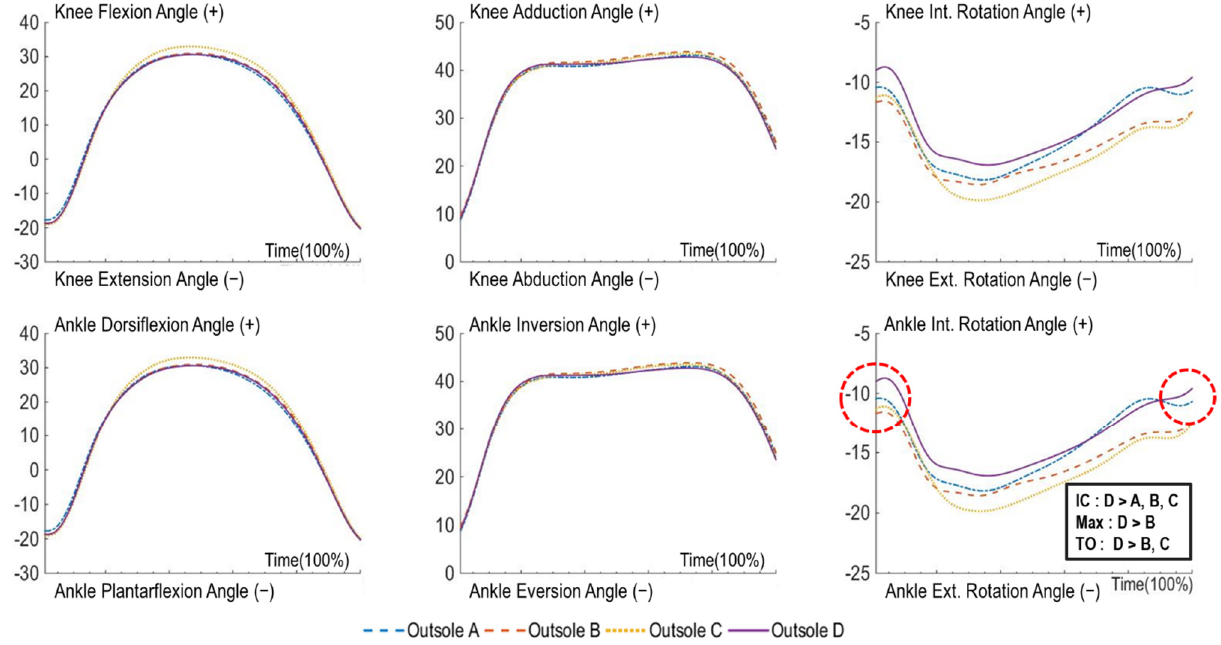
Figure 5. Knee and ankle joints’ angle patterns (mean of 11 participants) upon side braking motion. IC: initial contact, Max: maximum joint angle, TO: toe off. (Dotted red circles represent the significant difference among the outsole tread patterns). Table 4. Maximum joint moments upon aide braking motion in a biomechanical analysis.